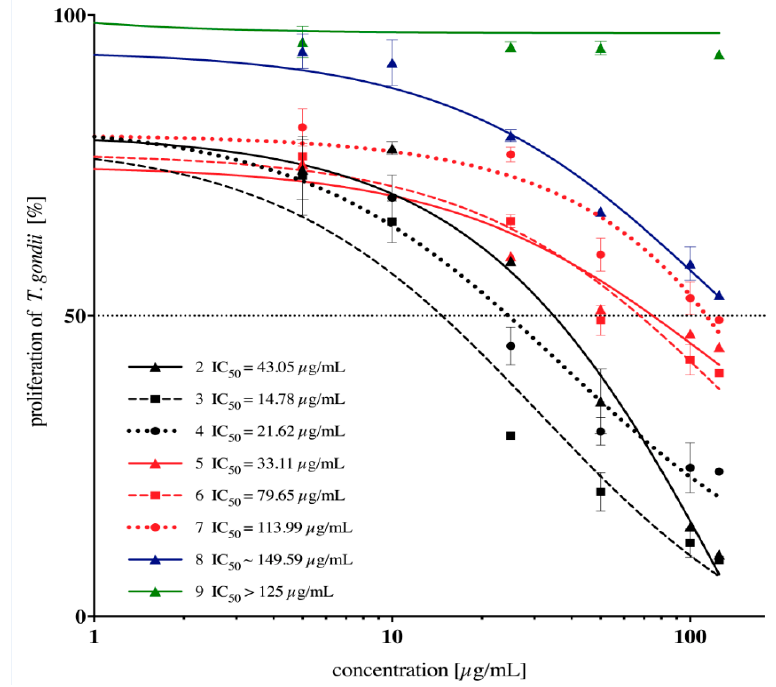
Figure 2. Dose response curves and IC 50 values [µg/mL] of compounds 2 – 9 on T. gondii proliferation.